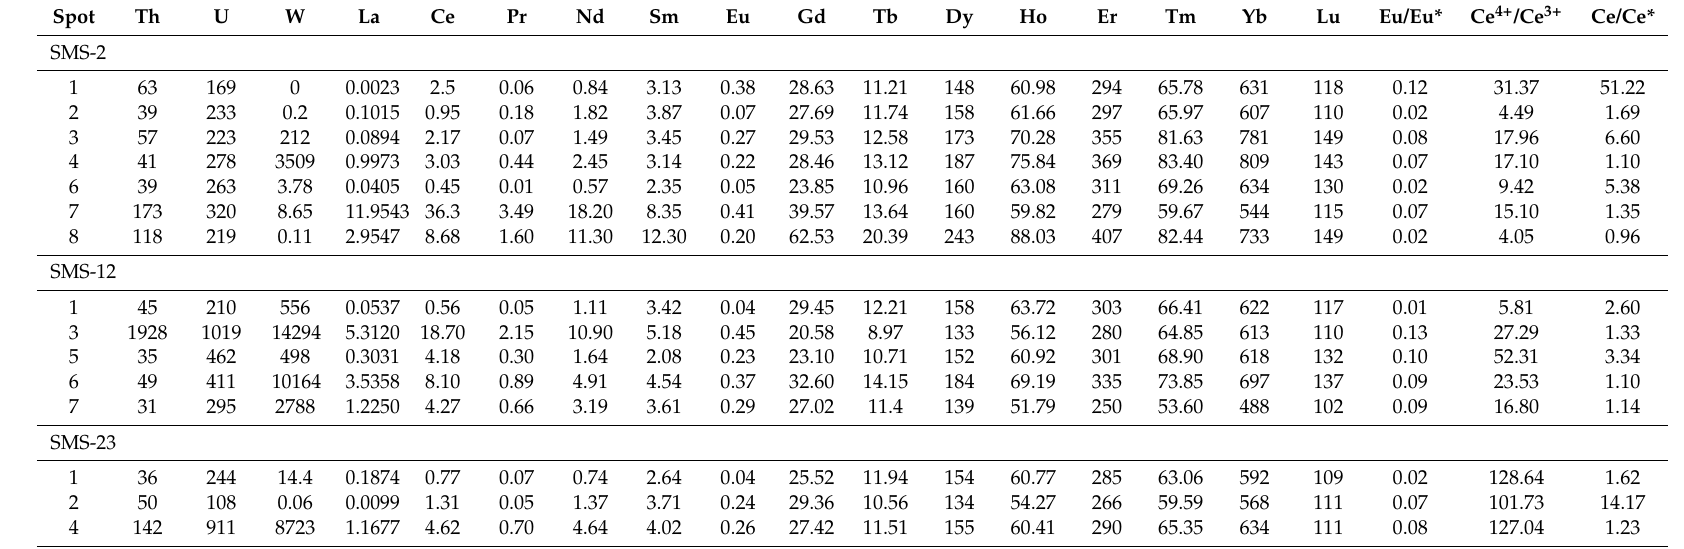
Table 5. LA-ICP-MS zircon trace element contents of the Shimensi granodiorite